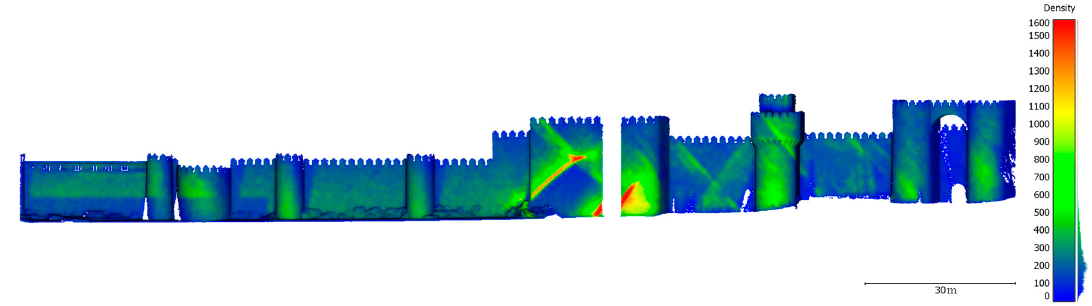
Figure 9. MLS point density distribution (points/m 2 ) for the southeast walls.